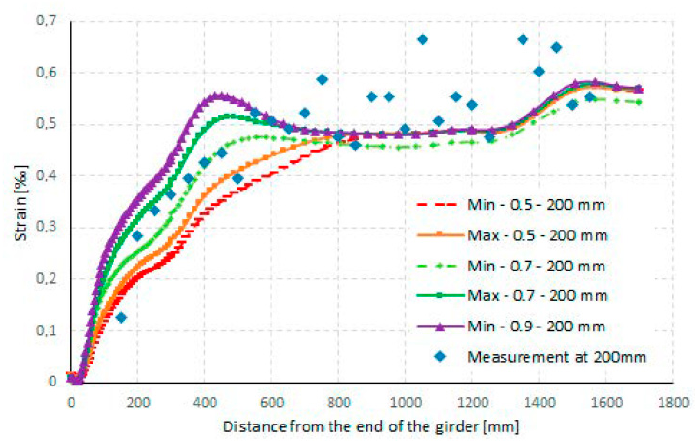
Figure 10. Comparison between FE models and DEMEC mechanical strain gauge measurements at a height of 200 mm from the bottom of the girder.